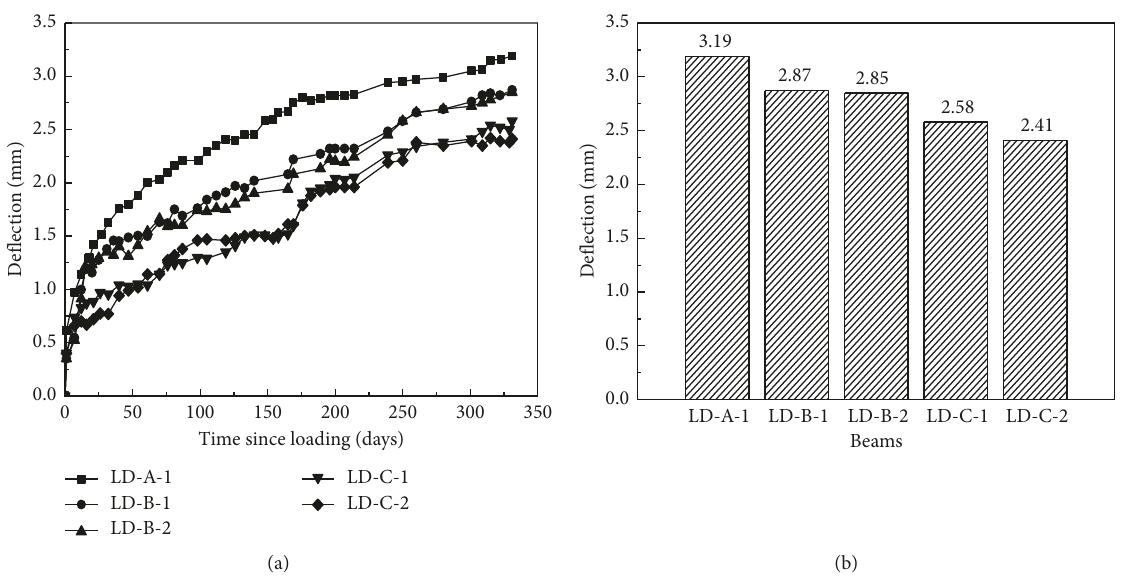
Figure 11: Long-term deflection of RC beams under different exposure conditions: (a) comparison of long-term deflection curves; (b) comparison of deflections at 331 days since